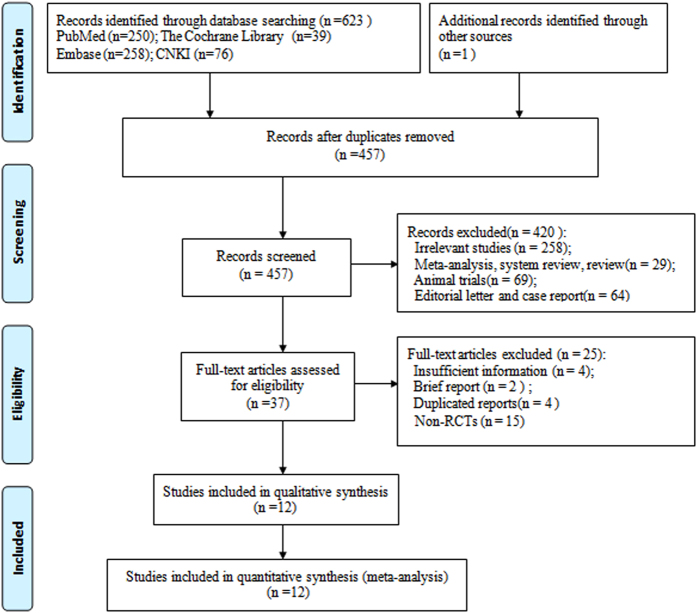
Flow diagram of the selection process for eligible studies.